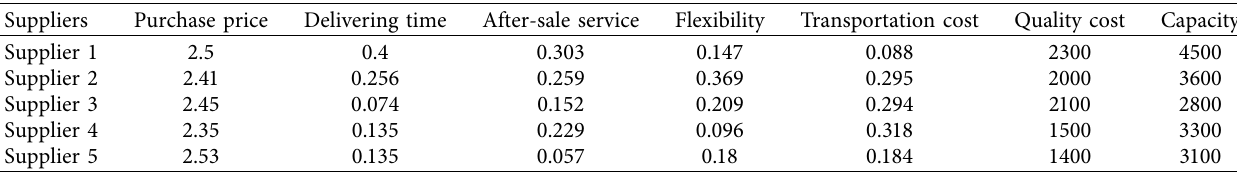
Figure 4: The optimal weight of criteria determined by the BWM. Table 6: Details of the suppliers of raw materials.